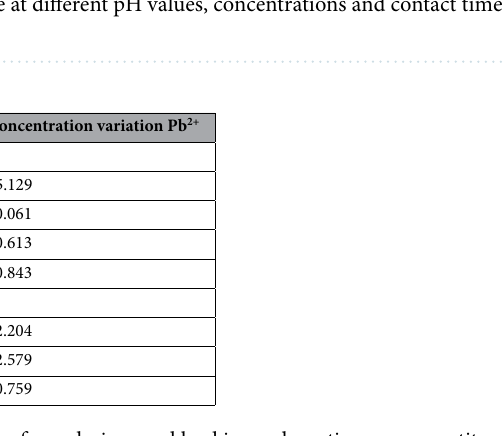
Table 4. Equilibrium isotherm parameters for cadmium and lead ions adsorption on magnetite material surfaces.